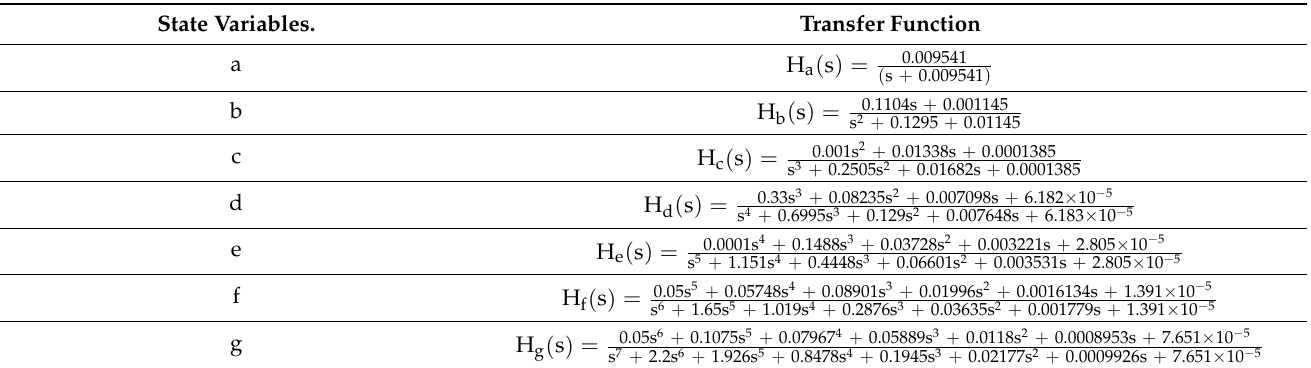
Table 3. Transfer function of the textile